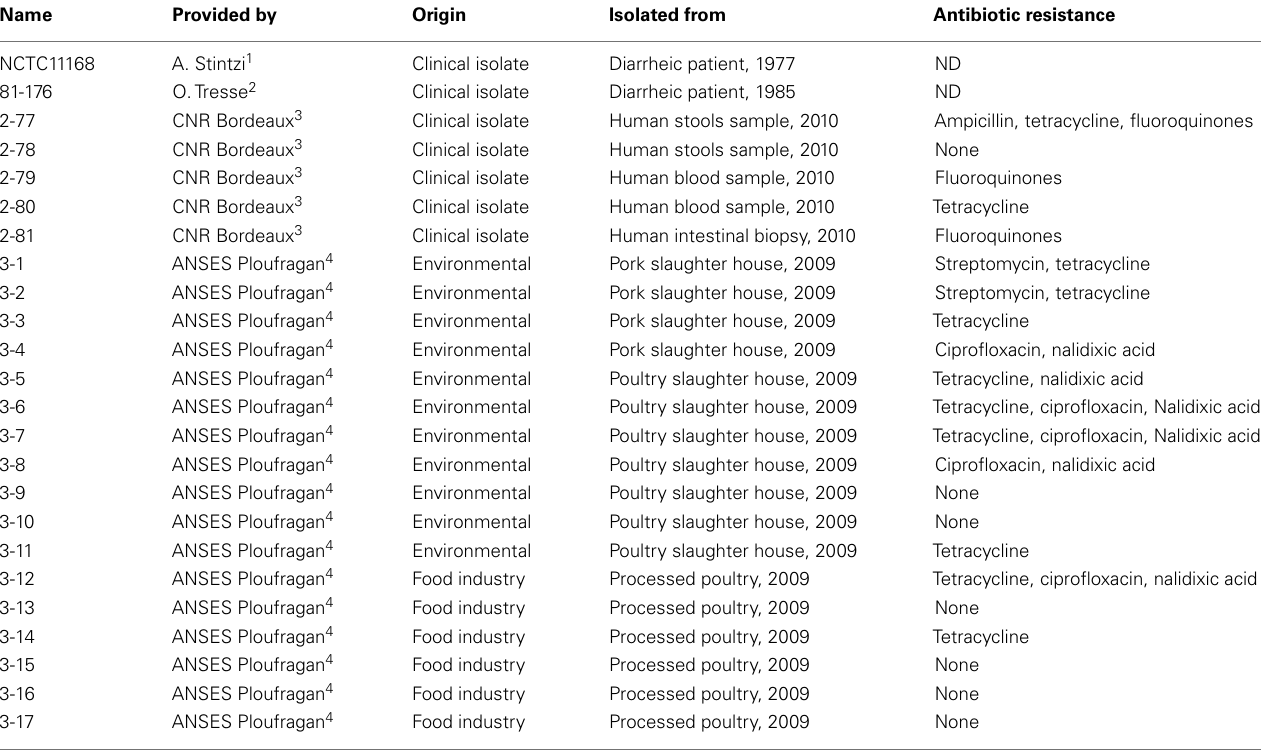
Table 1 | Campylobacter jejuni isolates used in this study and some of their